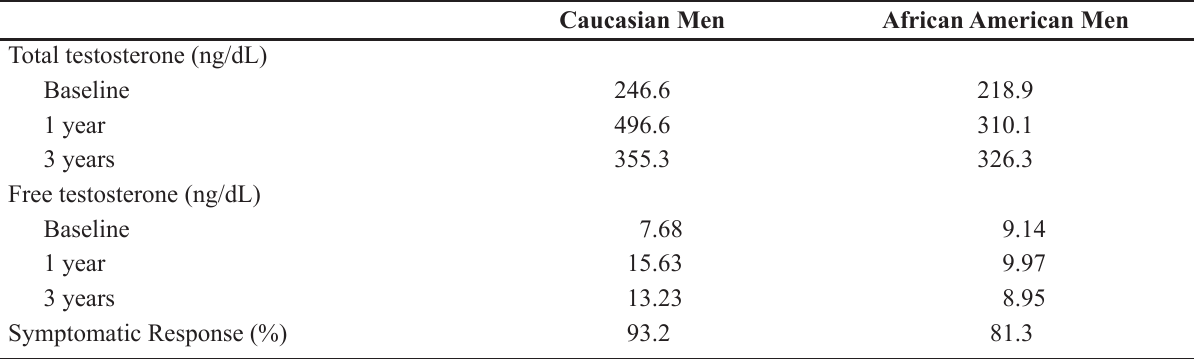
Table 2 – Racial differences in biochemical and symptomatic responses to